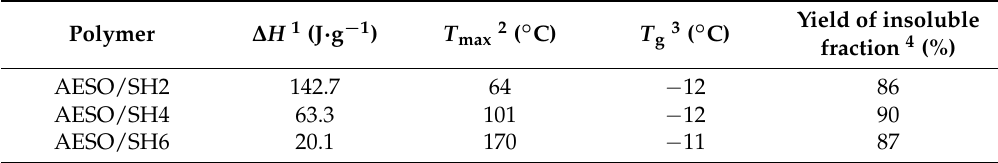
Table 1. Reaction enthalpies, temperatures of the curing exotherm maximum, and glass transition temperatures for the different formulations yields of insoluble fraction of cross-linked